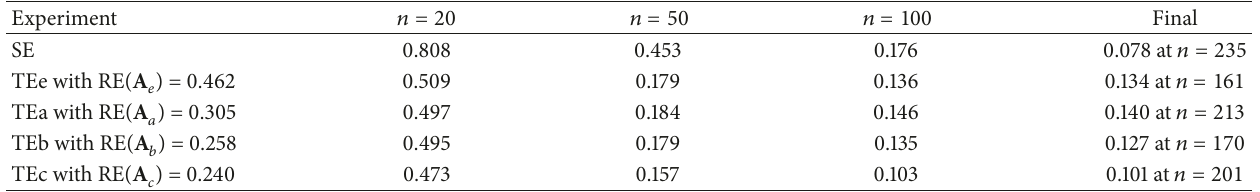
Table 6: As in Table 5 but for the two-dimensional case in Figure 12 where the third set of innovations is used without periodic extension. Experiment 𝑛 = 20 𝑛 = 50 𝑛 = 100 Final SE 0.808 0.453 0.176 0.078 at 𝑛 = 235 TEe with RE( A 𝑒 ) = 0.462 0.509 0.179 0.136 0.134 at 𝑛 = 161 TEa with RE( A 𝑎 ) = 0.305 0.497 0.184 0.146 0.140 at 𝑛 = 213 TEb with RE( A 𝑏 ) = 0.258 0.495 0.179 0.135 0.127 at 𝑛 = 170 TEc with RE( A 𝑐 ) = 0.240 0.473 0.157 0.103 0.101 at 𝑛 =